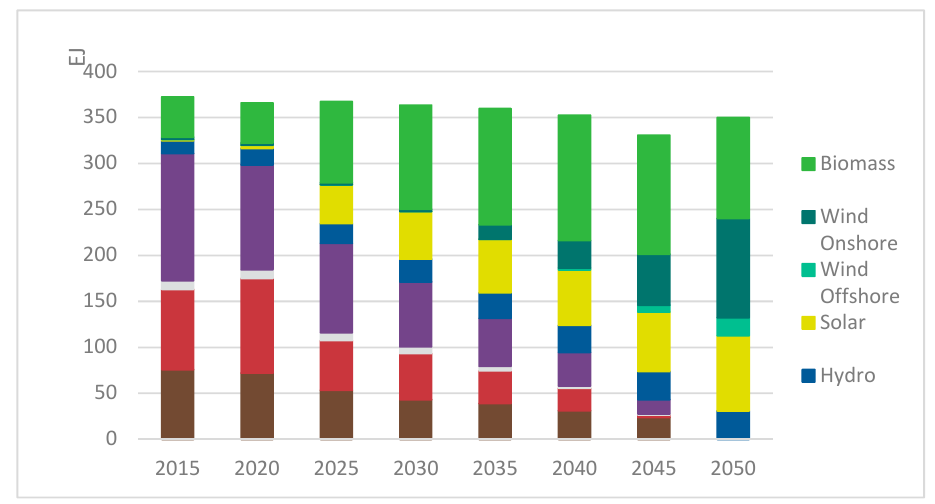
Figure 4. Development of the global energy mix (final energy supply) with a CO 2 -budget of 650 Gt.